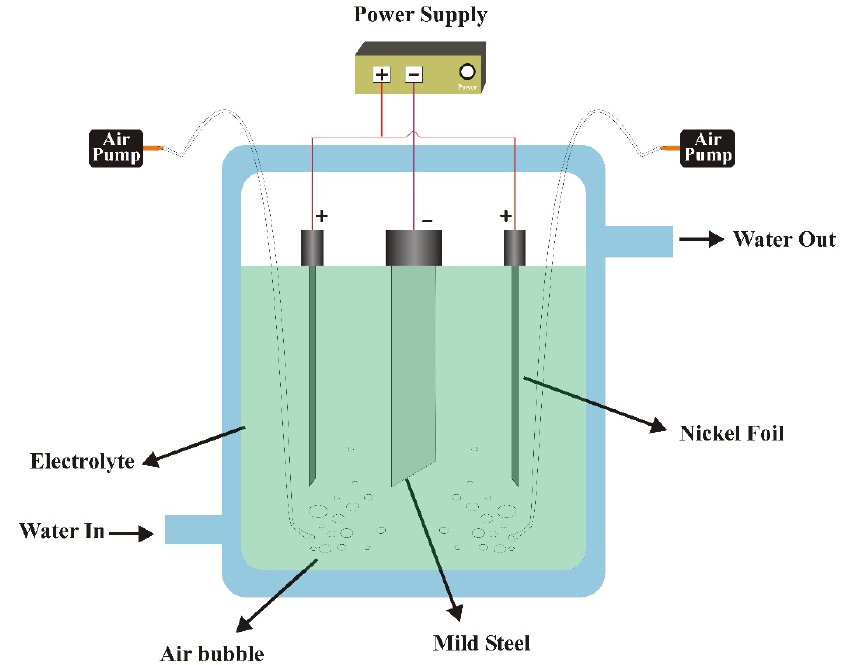
Figure 1. Schematic diagram of the electroplating setup used to deposit pure Zn, Zn-Ni and pure Ni coatings.